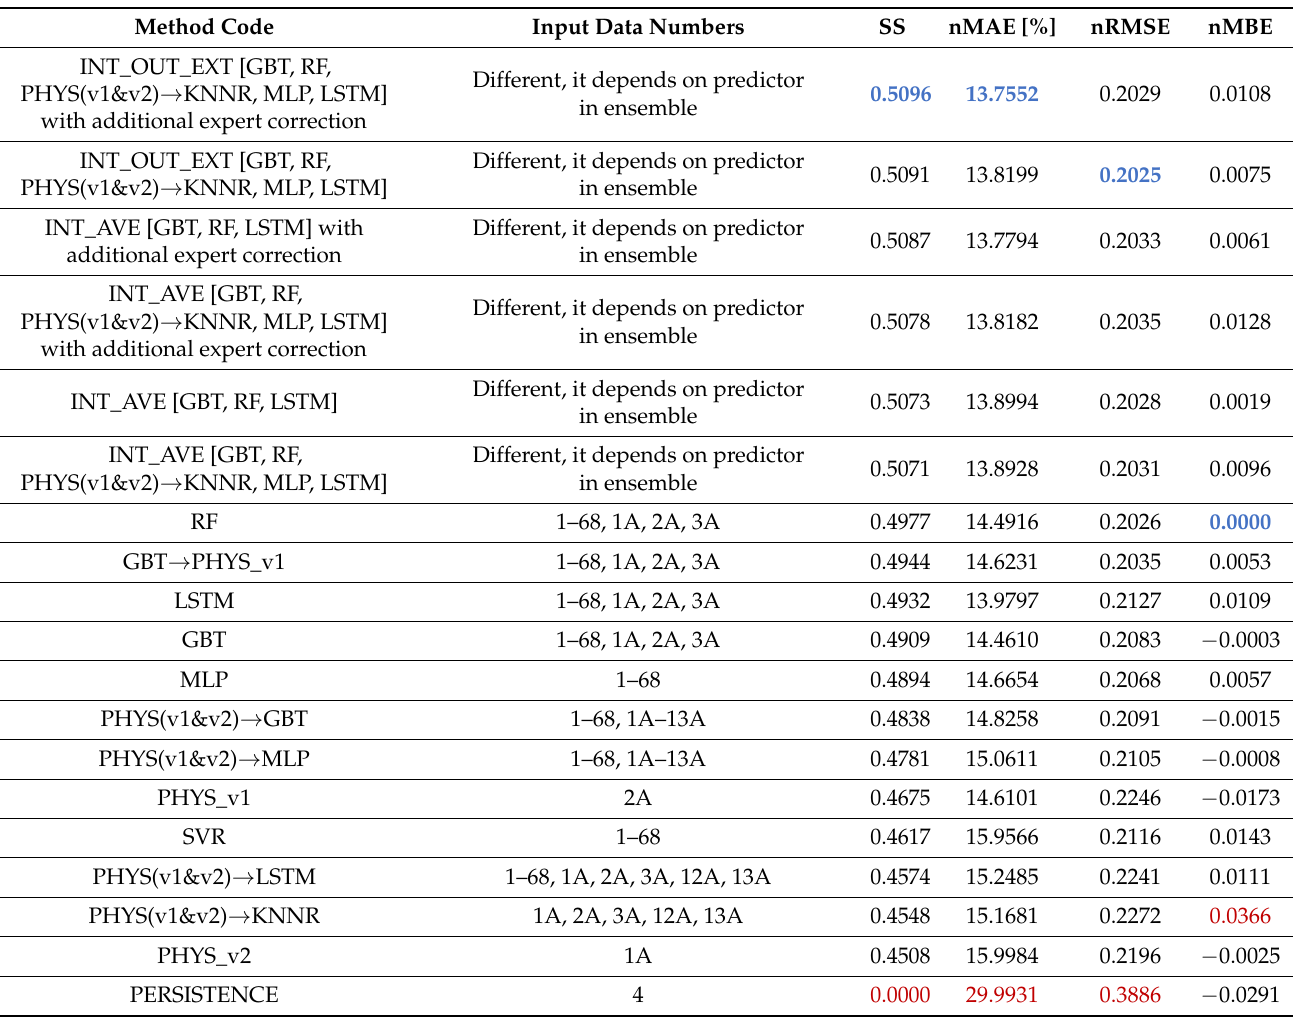
Table 10. Measures of performance of the proposed single, ensemble and hybrid methods with different sets of input data (test subset) for Wind Farm